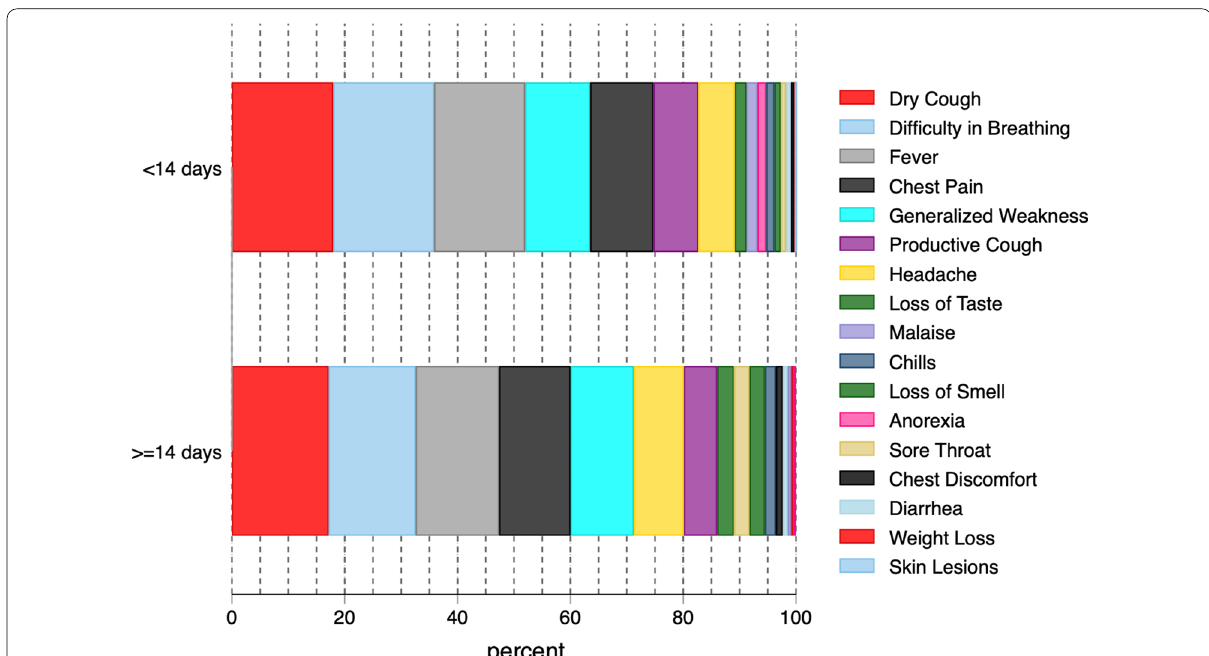
Fig. 1 Symptoms comparison between patients hospitalized for 14 days or more and those who were hospitalized for less than 14 days.